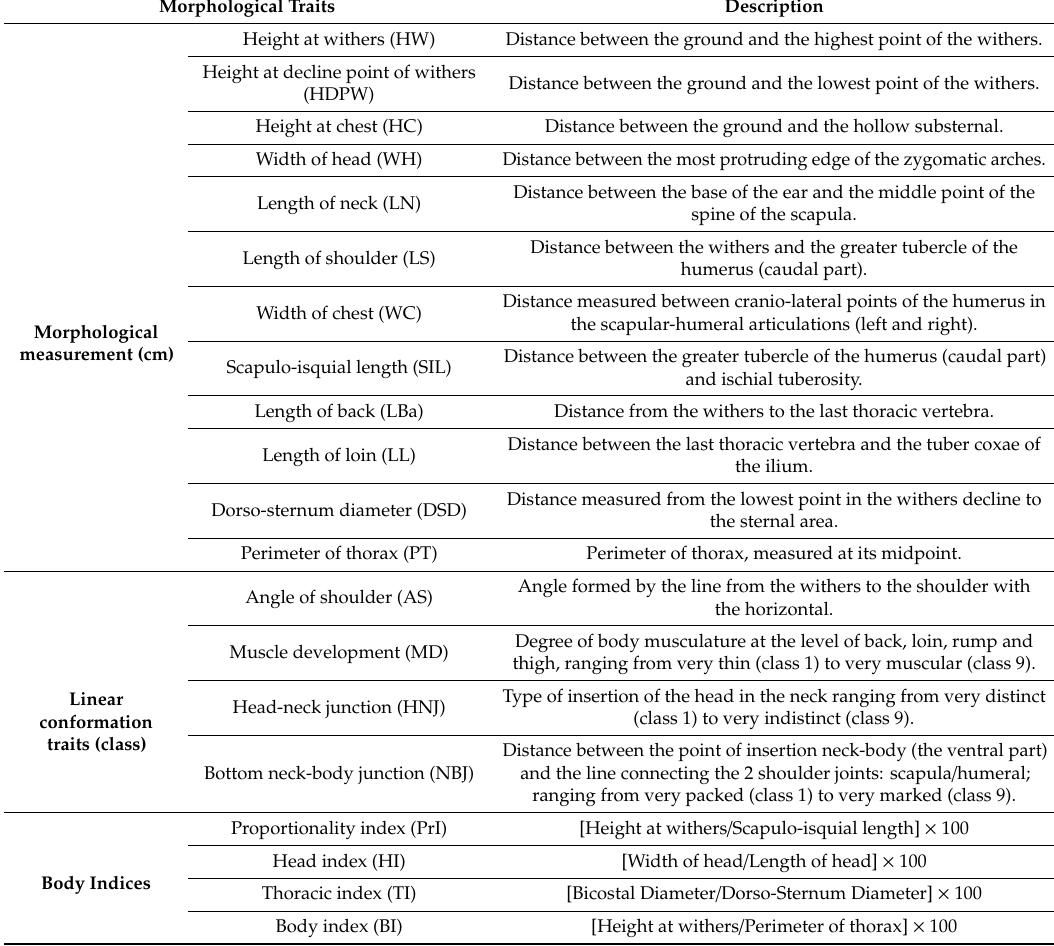
Table 1. Description of the 16 morphological traits and 5 body indices analyzed in the Pura Raza Español